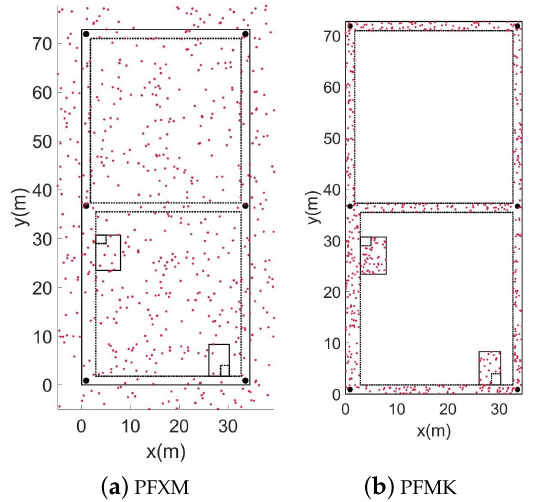
Figure 3. Feasible domain distribution of particles under different